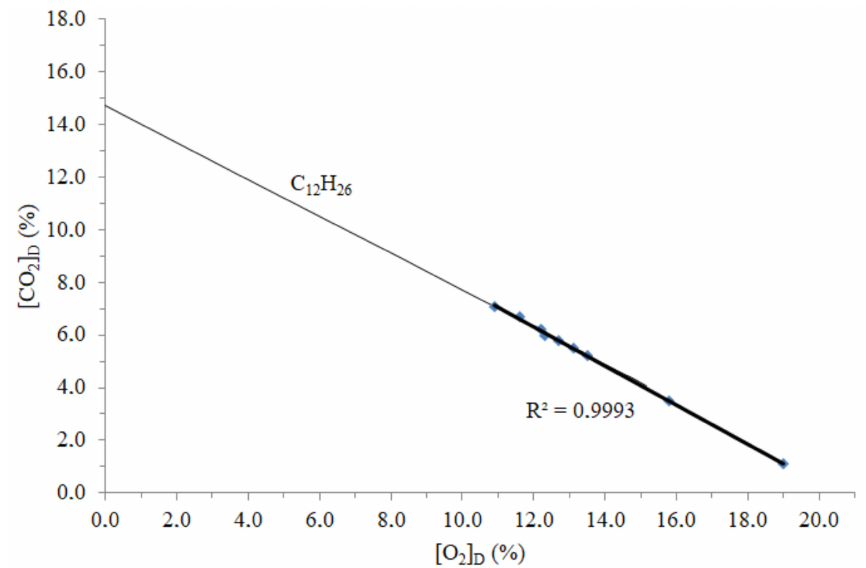
Figure 2. The CO 2 concentration as a function of O 2 concentration, both on a dry basis, for diesel fuel combustion in locomotives. Experimental data source: